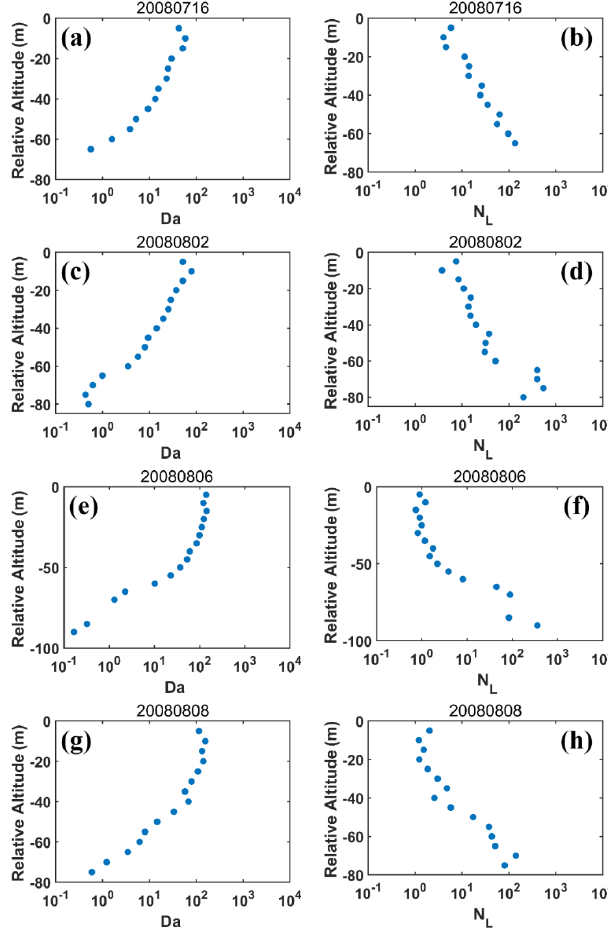
Figure 4. Height dependence of Damköhler number ( Da ) on (a) 16 July 2008, (c) 2 August 2008, (e) 6 August 2008 and (g) 8 Au- gust 2008; height dependence of transition scale number ( N L ) on (b) 16 July 2008, (d) 2 August 2008, (f) 6 August 2008 and (h) 8 August 2008. The relative altitude on the y axis equal to 0 rep- resents the cloud tops. Adiabatic liquid water content (LWC a ) is obtained by the adiabatic growth from cloud base, adiabatic num- ber concentration ( n a ) is assumed to be the maximum volume mean radius at each level, and adiabatic volume mean radius ( r va ) is cal- culated with LWC a and r va .